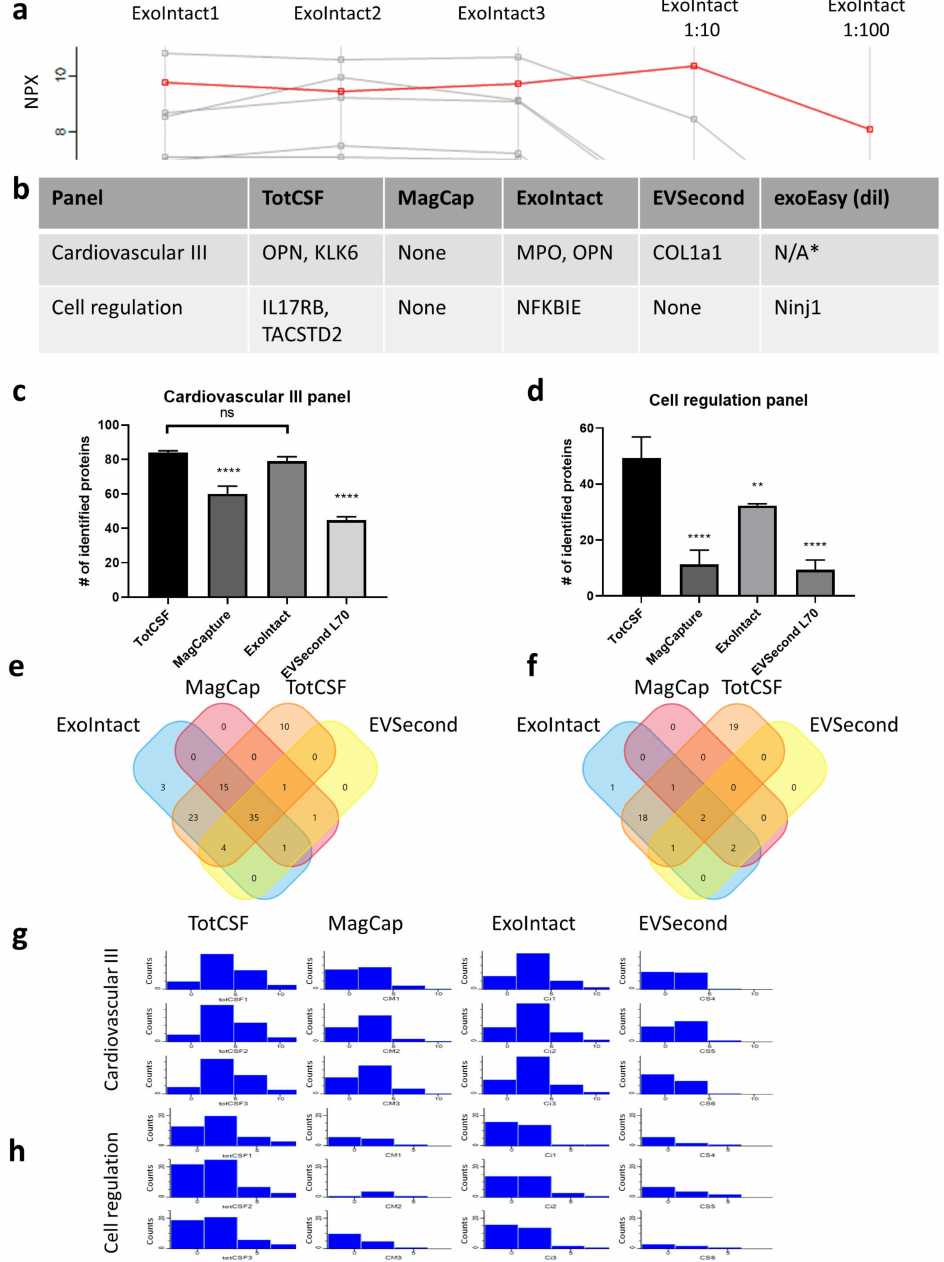
Figure 3. Hook analysis and protein abundance distribution. ( a ) Profile plot indicating one protein that was excluded due to a hook e ff ect (OPN marked in red). ( b ) List of analytes that showed a hook e ff ect from each panel and group; * indicates samples that could not be analyzed due to not meeting quality control criteria. ( c , d ) Number of proteins identified in each group in the cardiovascular III panel ( c ) and in the cell regulation panel ( d ). ( e , f ) Venn diagram of proteins detected in all three replicates of each group for cardiovascular III ( e ) and cell regulation panels ( f ). ( g , h ) Distribution histograms for each sample, showing the signal strength on the horizontal axis and the number of detected proteins on the vertical axis for the cardiovascular III ( g ) and cell regulation panels ( h ). The median coe ffi cient of variation was calculated using markers with 100% detection rate in all groups. Bar charts represent n = 3; significance determined by one-way analysis of variance with Tukey’s multiple comparison, compared to TotCSF samples. Significance was labelled as ns for not significant, * p ≤ 0.05, ** p ≤ 0.01 and **** p ≤ 0.0001. Tot CSF: total CSF, MagCap: MagCapture, dil: